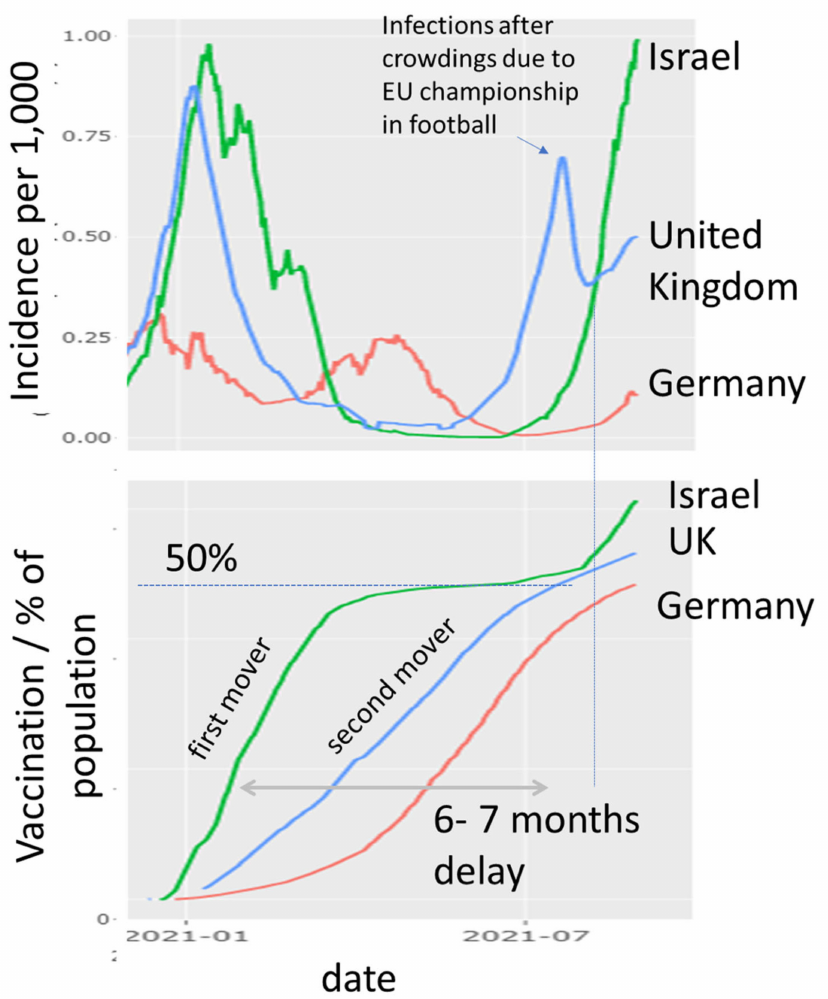
Figure A13. Breakthrough infections after vaccination? Israel was the first vaccination mover reaching vaccination of about 50% of population in February–March 2021. About 6–7 months later the incidence of COVID-19 (delta variant) strongly gains because of unclear reasons. Possible factors are: (i) The amount of vaccination remained clearly below herd immunity level (>80%). (ii) Insufficient and/or waning protection due to immune evasion of SARS-CoV-2 delta. A recent study demonstrated that natural immunity confers longer lasting and stronger protection against infection, symptomatic disease and hospitalization caused by the delta variant of SARS-CoV-2, compared to the BNT162b2 (Biontech-Pfizer) two-dose vaccine-induced immunity [53]. The waning protection is possible due to the too short interval between first and second dose (3–6 weeks) [40]. Delayed intervals of 8–12 weeks provide much higher antibody titres reflecting stronger humoral and cellular immune responses Moreover, the ‘second moving’ country UK shows an increasing incidence after a first peak, which associated with crowds gathering during the European Cup in football. These facts possibly reflect immune evasion of the virus leading to waning immune response which raises the need of repeated booster vaccinations. Plots of incidence and vaccination data were taken from https://www.izbi.uni-leipzig.de/current-projects/covid19-viewer/ accessed on 30 August